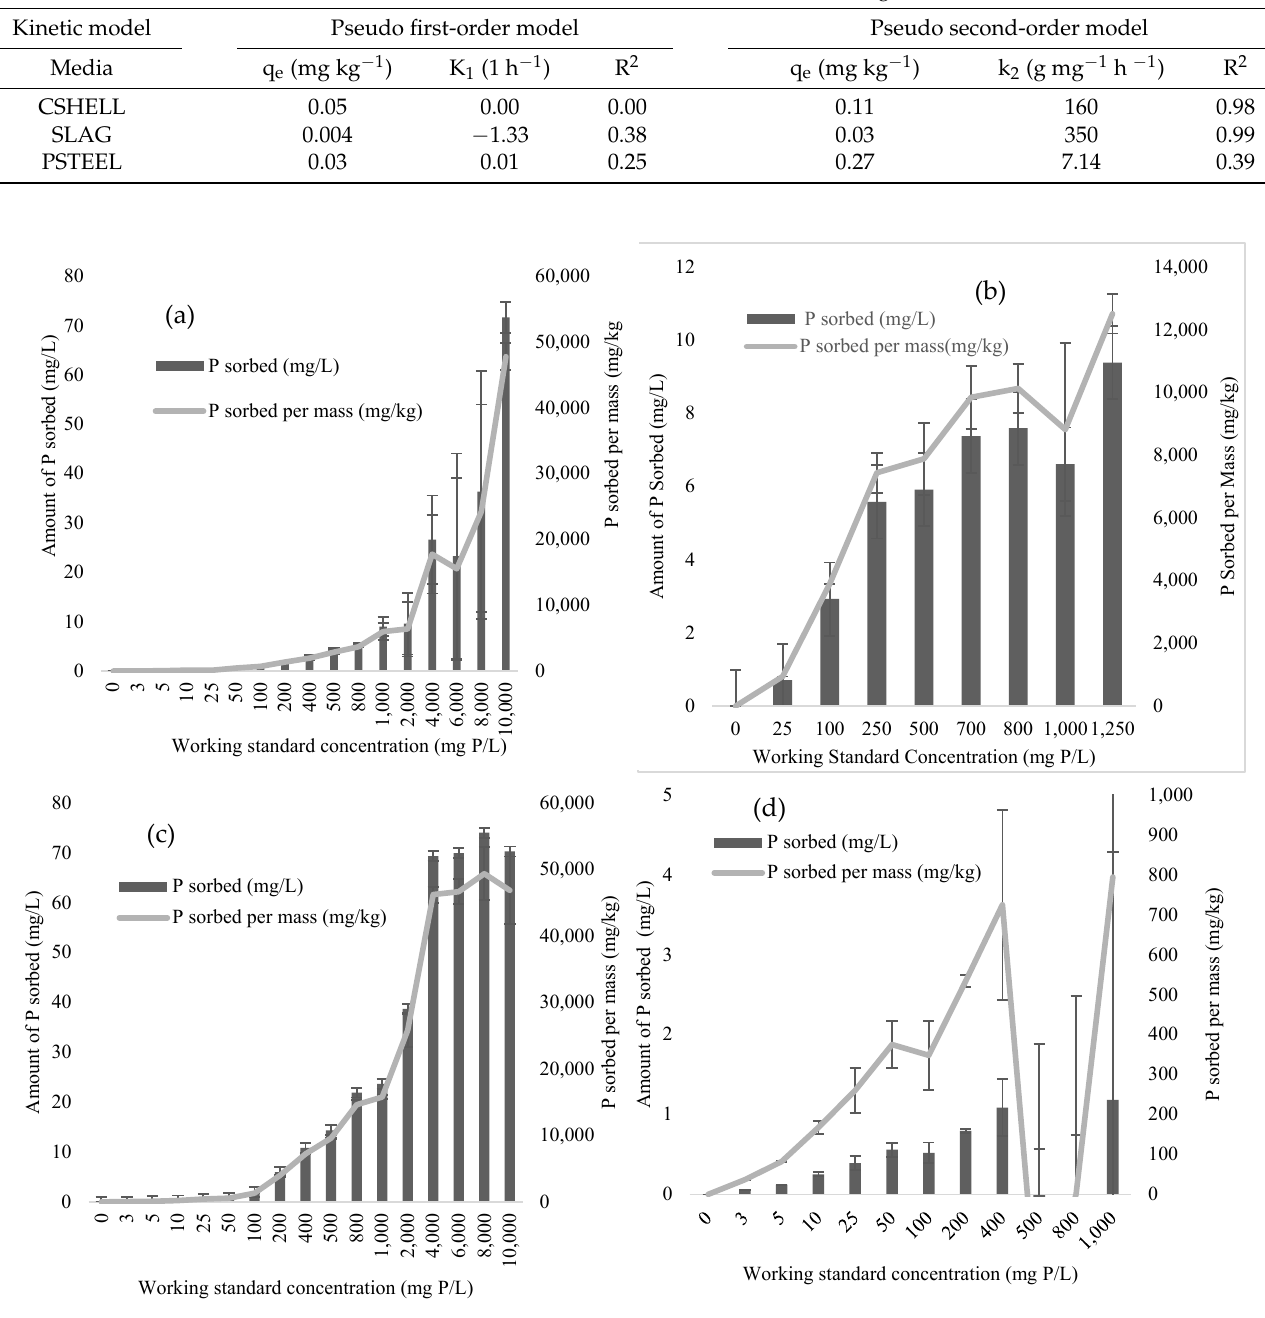
Figure 3. Sorption with increasing concentration for: ( a ) CSHELL; ( b ) SLAG; ( c ) MGBC; ( d ) STEEL.